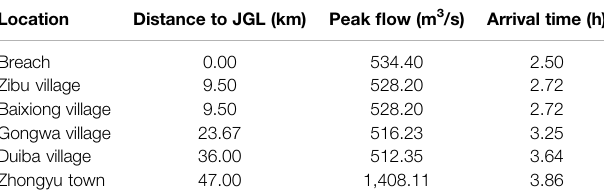
TABLE 4 | Peak fl ow and arrival time at different villages.